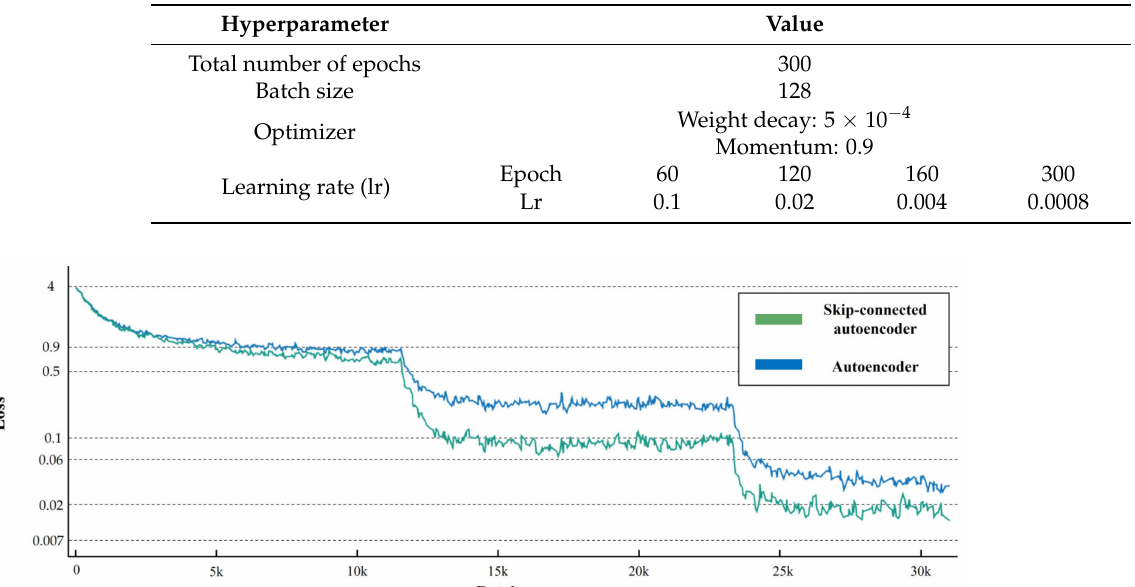
Table 4. Training hyperparameter settings of the autoencoder and skip-connected autoencoder.